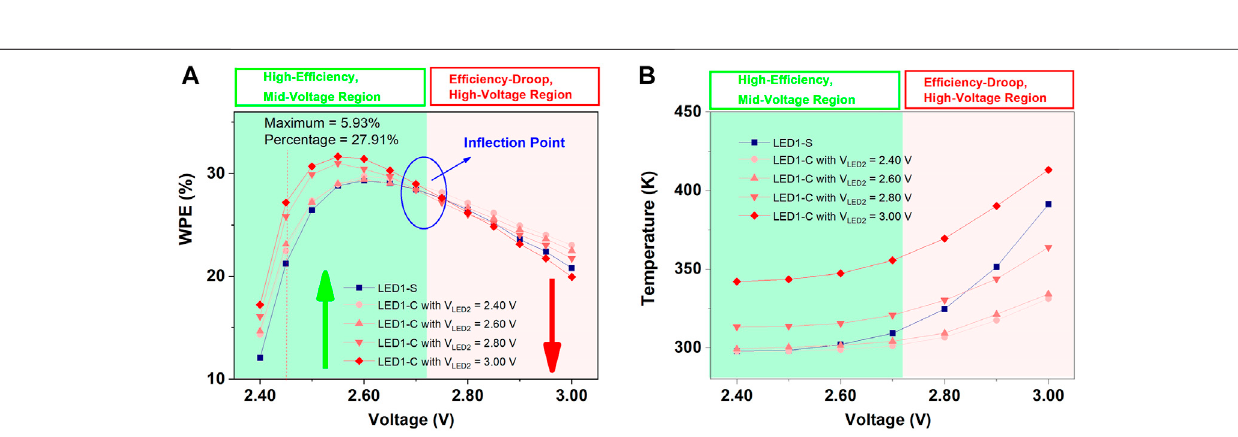
FIGURE 5 | (A) Experimental CEE and corresponding ef fi ciency improvement for modi fi ed Combined-LEDs and Separated-LEDs setups versus applied voltage and (B) electrical input power.